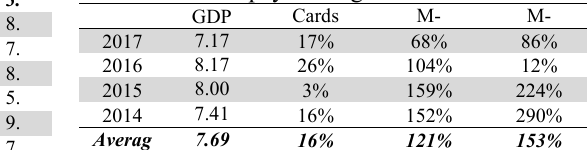
Economic and e-payments growth rates for